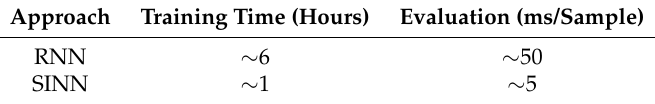
Table 2. Training of both approaches was done using a machine equipped with a single